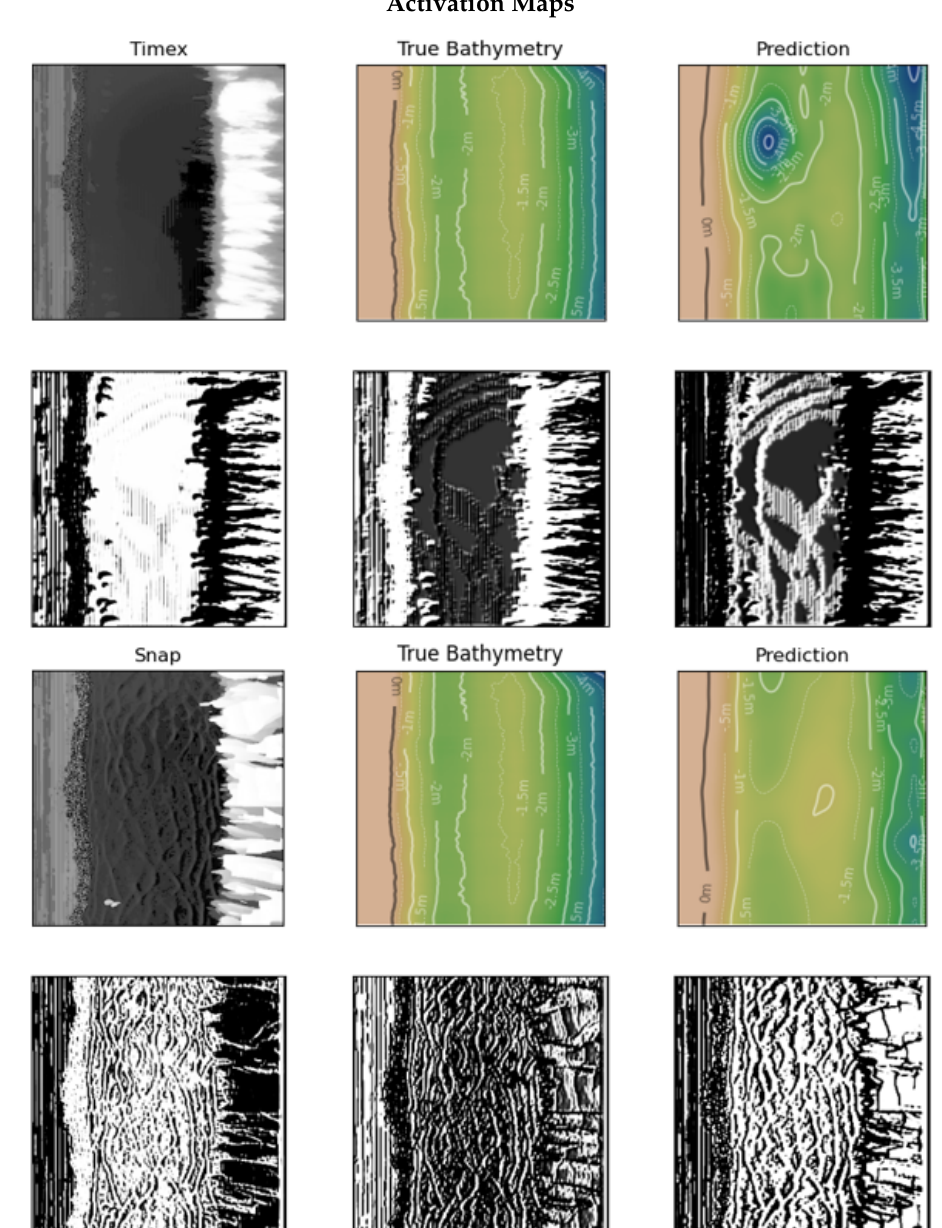
Figure 10. Three example activations from the FCNN with timex and snapshot-only input. Colorscale goes from black (unactivated) to white (activated). The first and third rows shows the input, ground truth bathymetry, and predicted bathymetry from each type of input. The second and fourth rows show sample activation maps from the input shown in the row above. The activation maps were randomly selected from the fourth batch normalization layer in the downward convolutional